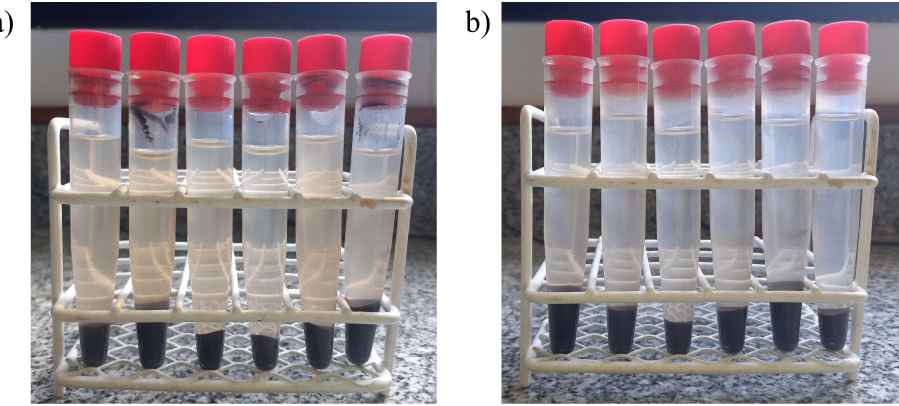
Figure 2. Silica-resin-bentonite nanocomposite CB in contact with the water solution of HNO 3 ; ( a ) pH = 3; ( b ) pH = 5. All the vials contain solid CB.